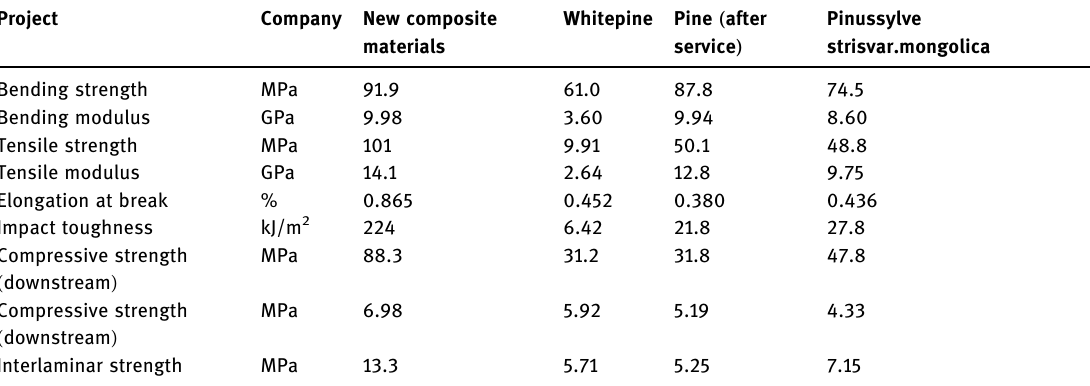
Table 2: Comparison of material performance indexes Project